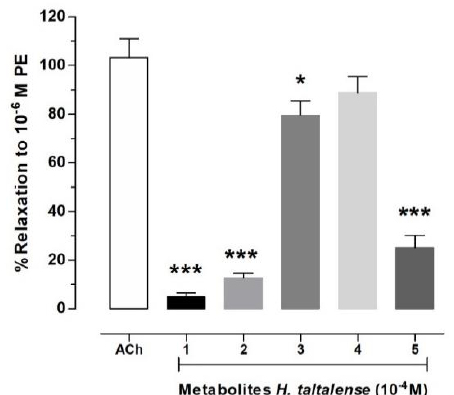
Figure 8. Isolated compounds from H. taltalense produced relaxation in intact rat aorta. Vascular relaxation of pinostrobin ( 1 ), pinocembrin ( 2 ), sakuranetin ( 3 ), rhamnocitrin ( 4 ), and 4,5 dihydroxy-3-geranyl-benzoic acid ( 5 ) were compared to ACh. Aortic rings were pre-contracted with 10 −6 M PE, and then, the metabolites or ACh (10 − 4 M) was added in organ bath. Data are SEM of 3 independent experiments. * p < 0.05; *** p < 0.001 vs. ACh.